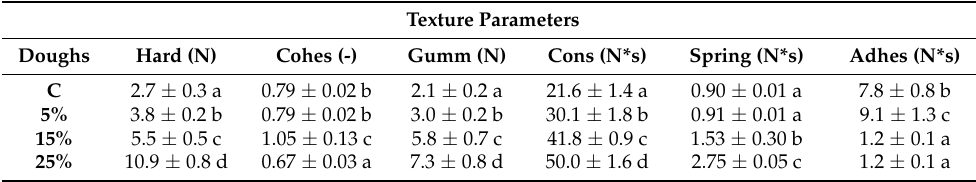
Table 4. Texture profile analysis of dough: wheat flour (control: C) and blends of wheat flour and oat flour at levels of 5, 15, and